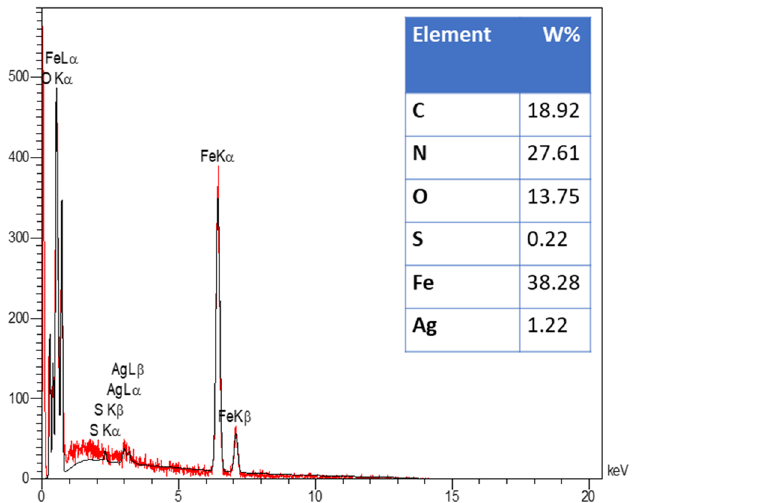
Figure 6. EDX analysis of Fe 3 O 4 -g-C 3 N 4 -Alg-Ag